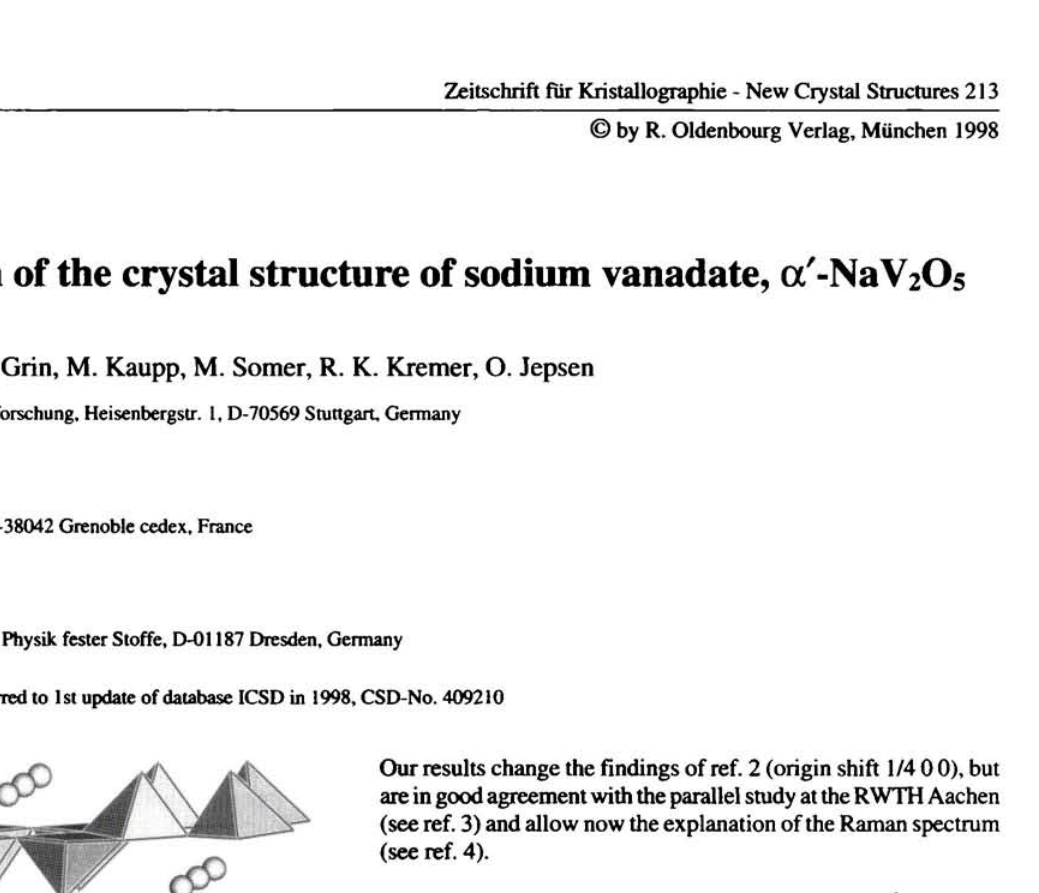
Our results change the findings of ref. 2 (origin shift 1/4 0 0), but are in good agreement with the parallel study at the RWTH Aachen (see ref. 3) and allow now the explanation of the Raman spectrum (see ref. 4).